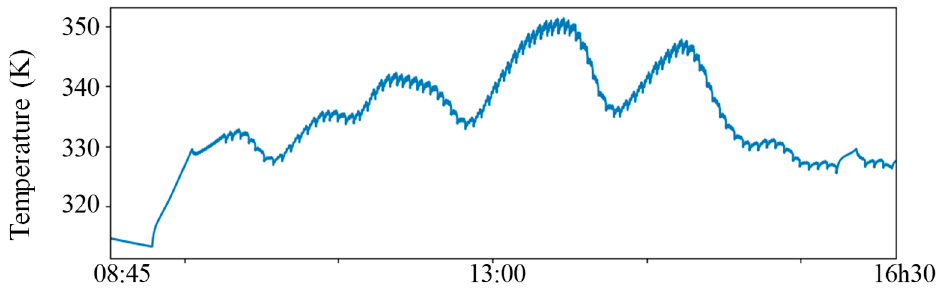
Figure 23. Simulated evaporator temperature over the disturbed day.